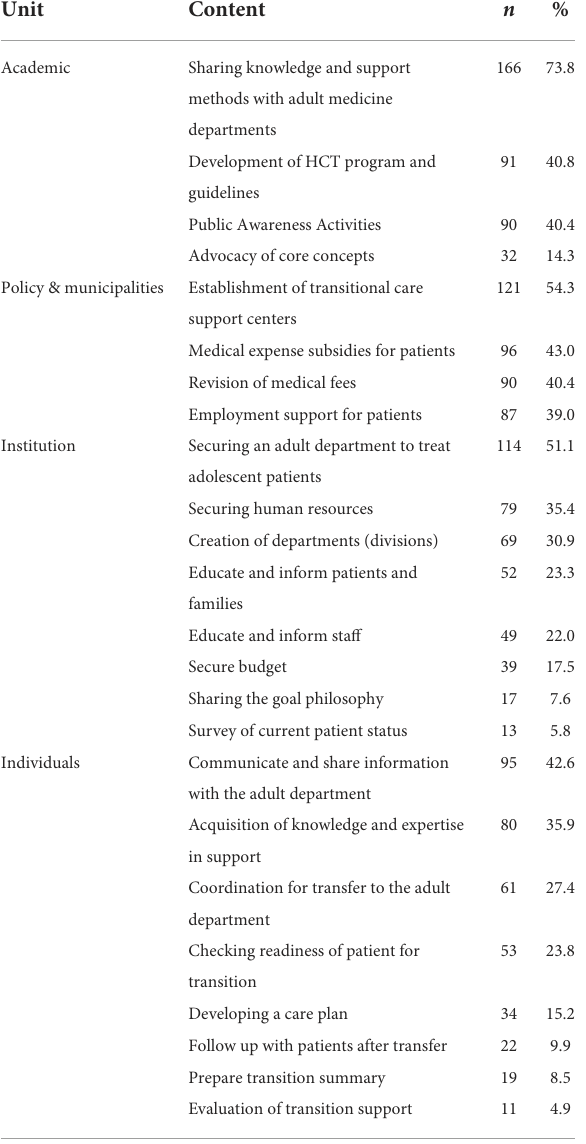
TABLE 4 Requests for transition support (Multiple Responses) n =